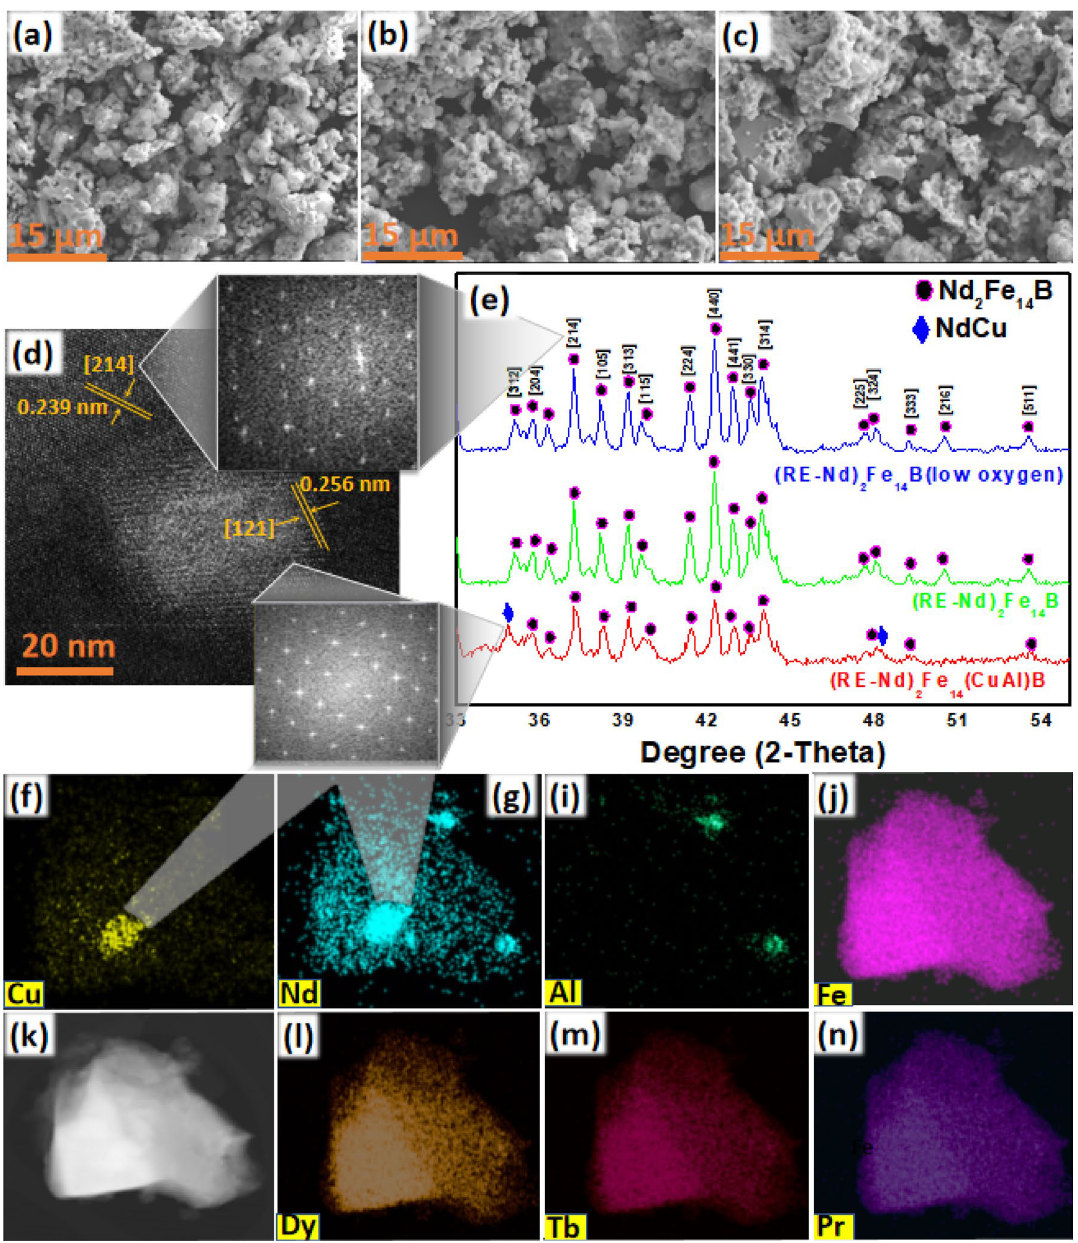
Figure 4. SEM images of ( a ) (Nd-RE) 2 Fe 14 (AlCu)B, ( b ) (Nd-RE) 2 Fe 14 B, ( c ) (Nd-RE) 2 Fe 14 B-(low oxygen), ( d ) HRTEM and SEAD patterns of (Nd-RE) 2 Fe 14 (AlCu)B, ( e ) XRD patterns for all three products, ( f – n ) TEM-EDS images of (Nd-RE) 2 Fe 14